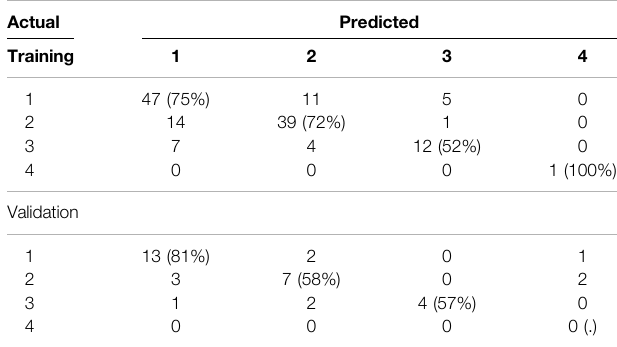
Actual Predicted Actual